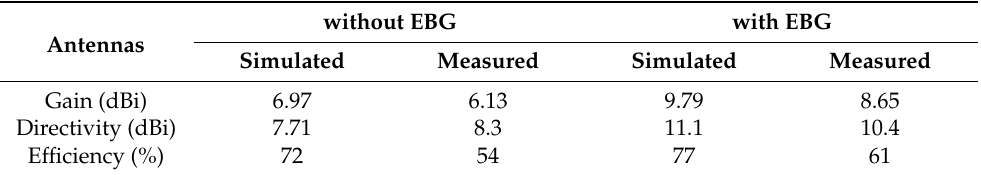
Table 2. Radiation parameters of the two patch antennas at 26 GHz. without EBG with Antennas